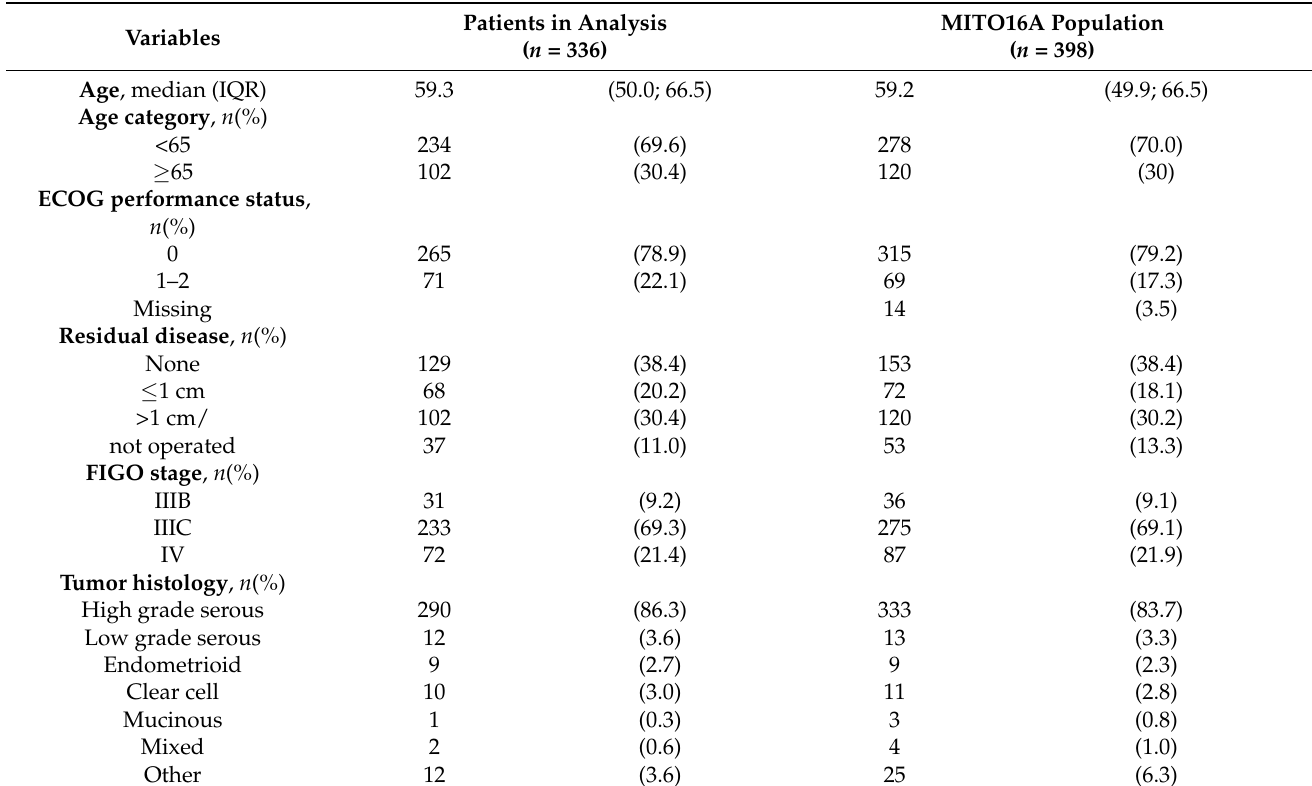
Table 1. Patient population in